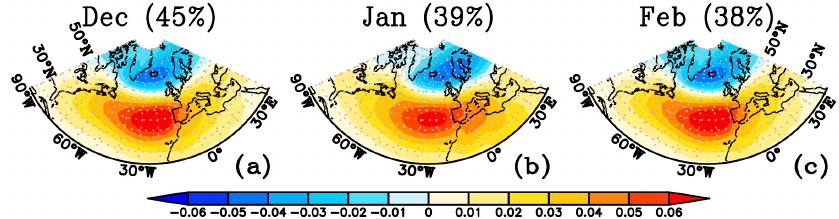
Figure 1. The first leading empirical orthogonal function (EOF) mode of the sea level pressure anomaly in December ( a ), January ( b ), and February ( c ) in the North Atlantic (20°–80° N, 90° W–40° E).